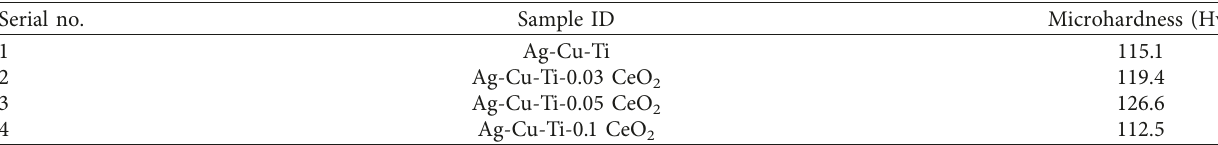
2 /Ti-6Al-4V joint. 2 (wt%).